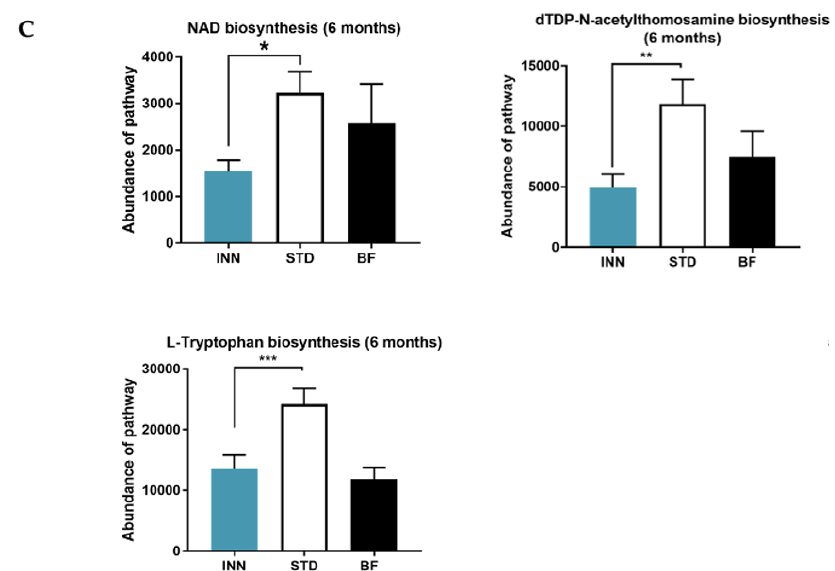
Figure 4. Major metabolic pathway categories relative to the abundance of each sample, including INNOVA formula (INN), standard formula (STD), and breastfeeding (BF). A. NAD biosynthesis (21 days), and Catechol degradation (21 days), B. Octane oxidation (2 months) and (S)-propane-1,2-diol deg (2 months), C. NAD biosynthesis (6 months), dTDP-N-acetylthomosamine biosynthesis (6 months), L-Tryptophan biosynthesis, * p < 0.05, ** p < 0.01, *** p < 0.001 and **** p < 0.001.